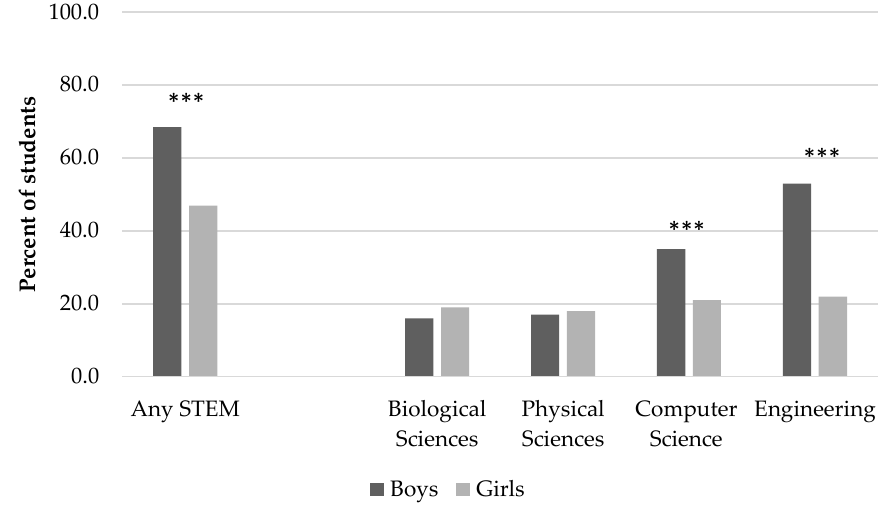
Figure 1. Expectations to major in STEM fields by gender among 9th grade students. *** p < 0.001, ** p < 0.01, * p < 0.05, ~ p < 0.10, two tailed test. 239